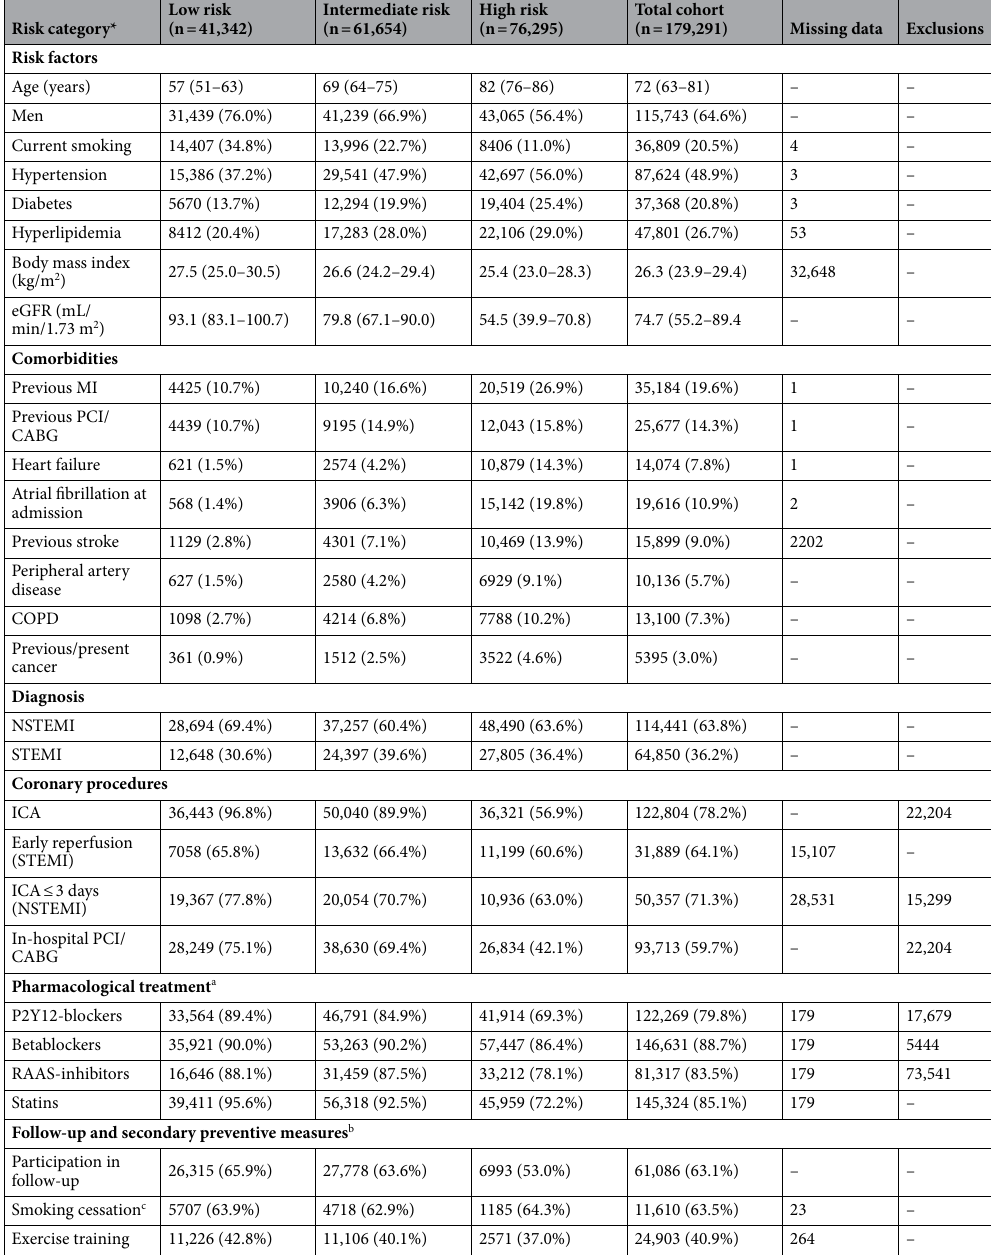
Table 1. Clinical characteristics and medical interventions in relation to GRACE 2.0 score categories. eGFR estimated glomerular filtration rate, MI myocardial infarction, PCI percutaneous coronary intervention,